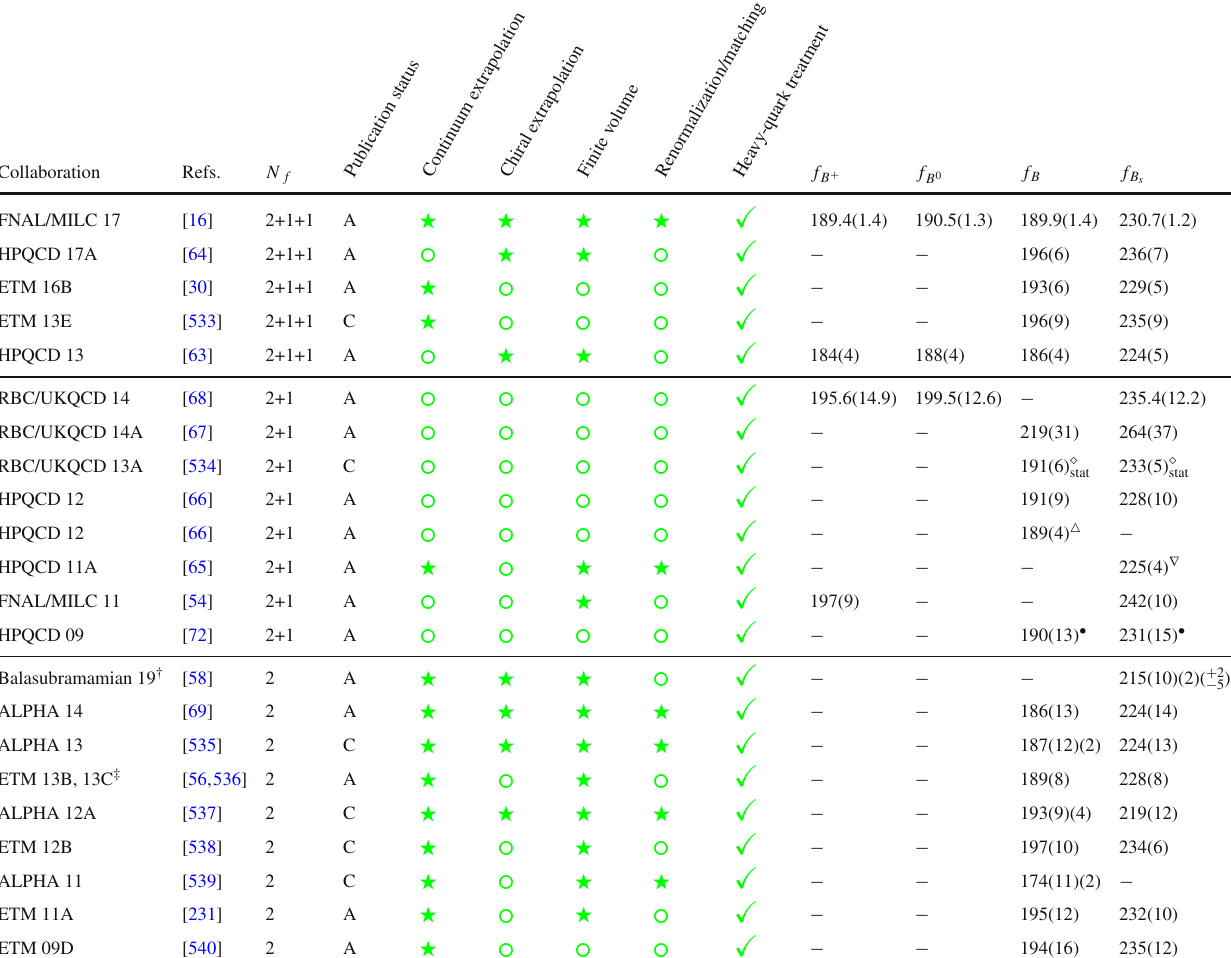
Table 41 Decay constants of the B , B + , B 0 and B s mesons (in MeV). Here f B stands for the mean value of f B + and f B 0 , extrapolated (or interpolated) in the mass of the light valence-quark to the physical value of m ud